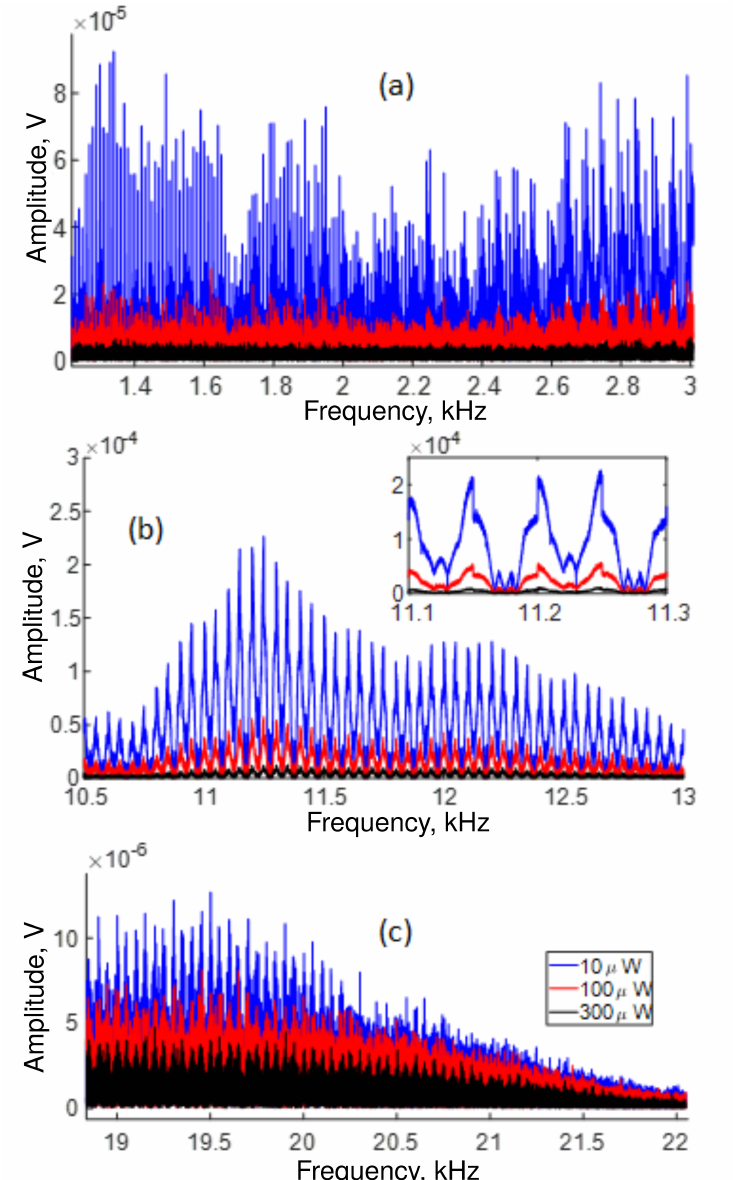
Figure 10. Frequency-dependent response of the system for several average power adjusted by the angle α of QWR (see Figure 1): ( a ) in the 2 kHz region, ( b ) around 11.2 kHz; ( c ) at high frequencies. For comparison, Figure 12 shows the response of a 10 m OFSI (the loop consists of two 5-m pieces of fiber, right- and left-twisted at 7 turns/m) when frequencies from 10 to 22 kHz are played mixed for ∼ 1.2 s. It is important to mention that the maximum average power, in this case, is ∼ 65 µ W. In contrast to Figure 4, different values of the average power in Figure 12 yield similar